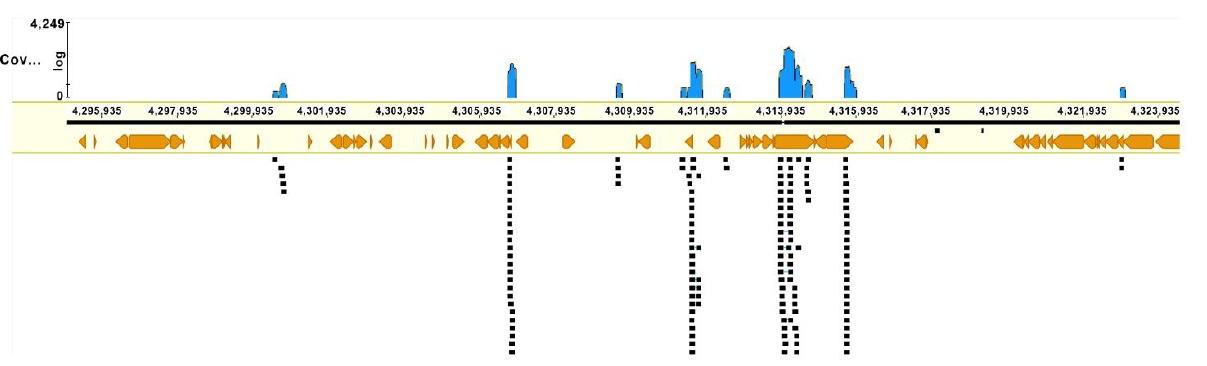
Figure 11. An example of mapping of reads in the region of the inversion. Black squares represent reads, and orange symbols denote repetitive DNA elements.